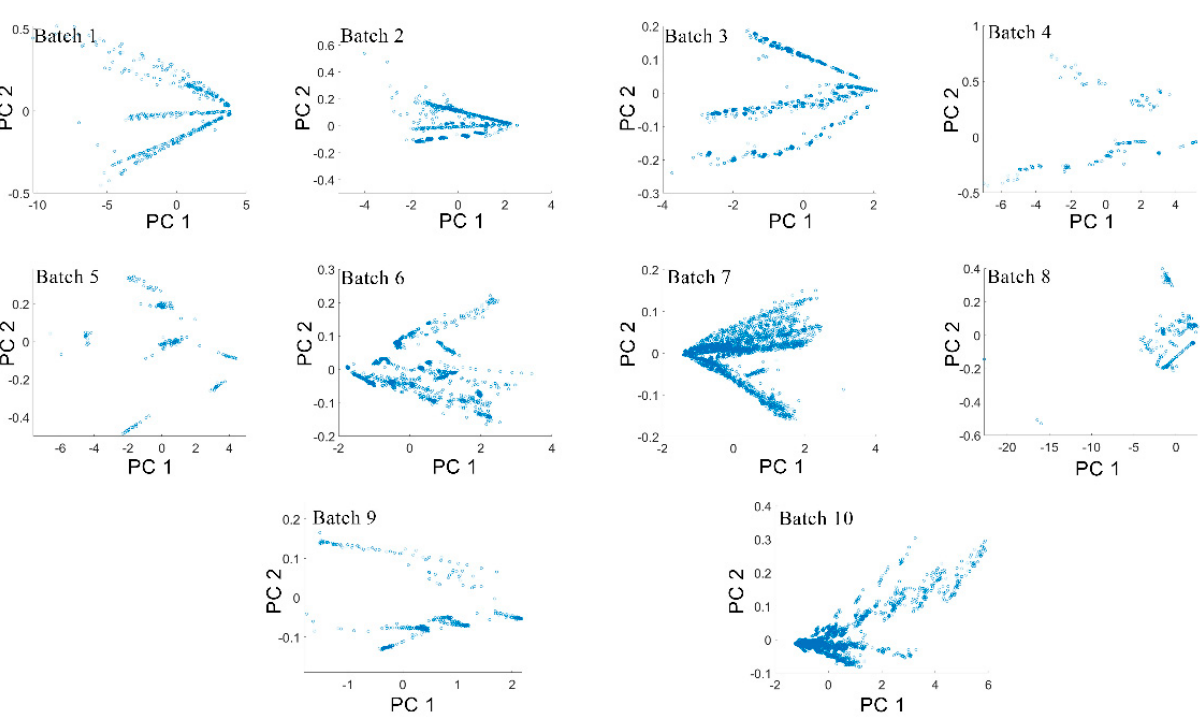
Figure 8. Distribution of principal components of 10 batches .